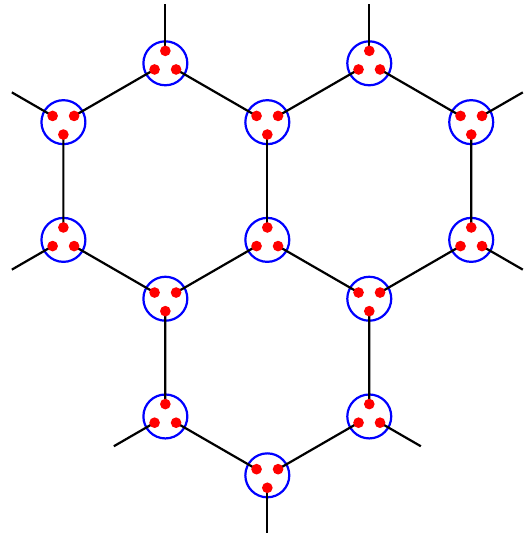
Figure 3: AKLT construction for spin- 3 system on honeycomb lattice. A red point 2 denotes one spin- 1 , and a blue circle on honeycomb site fuse three spin- 1 2 spin- 3 . A bond connecting two spin- 1 ’s projects them to a spin 2 2